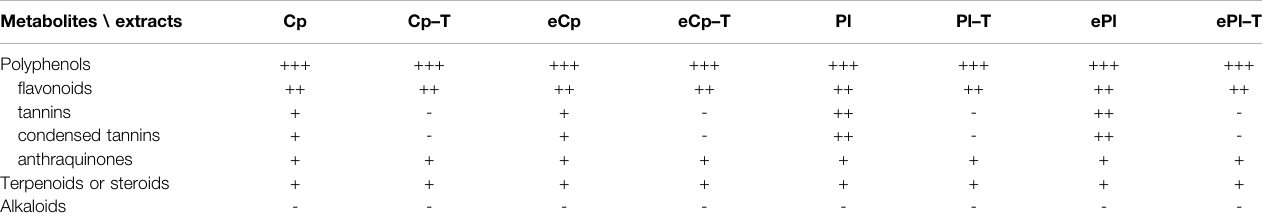
TABLE 2 | Phytochemical screening of the most active plants. Cp: Carapa procera DC.; Pl: Pericopsis laxi fl ora (Benth. ex Baker) Meeuwen; e: ethanol/water (50:50) eco- extract (crude methanolic extract otherwise); “ − T ” : after tannins removal; ( − ) absence or (+) presence of phytochemicals. Metabolites \ extracts